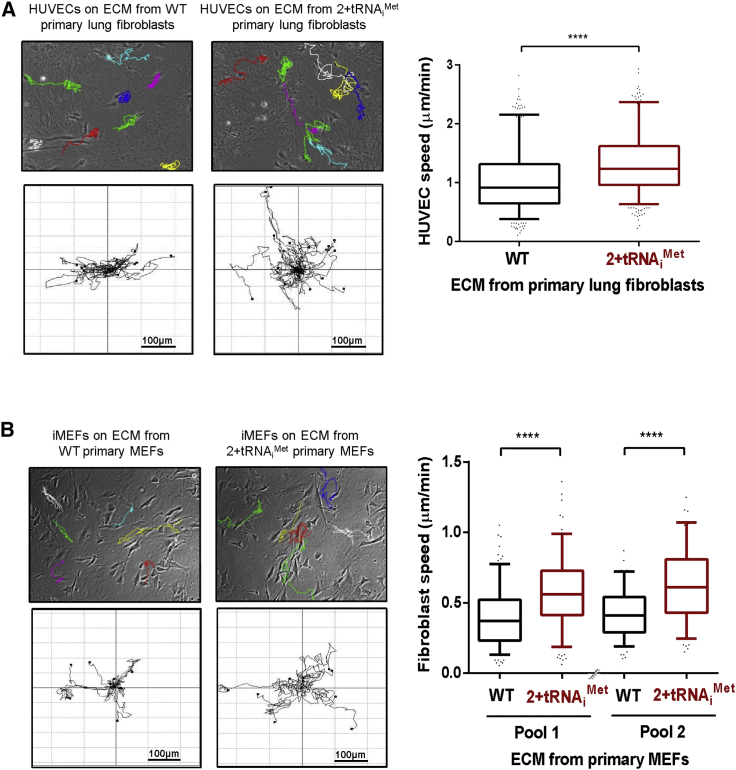
Fibroblasts Isolated from 2+tRNAiMet Transgenic Mice Deposit a Pro-migratory ECM(A) Extracellular matrix (ECM) was generated from primary lung fibroblasts isolated from either wild-type (WT) or 2+tRNAiMet transgenic mice. See Figure S2 for characterization of these cells. Migration of human umbilical vein endothelial cells (HUVECs) on the ECM was recorded by time-lapse microscopy and analyzed using ImageJ. Data represent ECM generated from seven independent isolates of primary fibroblasts from pools of three WT and three 2+tRNAiMet transgenic mice, tracking the migration of at least 28 HUVECs in each replicate. Box and whisker plot represents 5–95 percentile; Mann-Whitney test; ∗∗∗∗p < 0.0001.(B) ECM was generated from primary fibroblasts isolated from either WT or 2+tRNAiMet primary mouse embryonic fibroblasts (MEFs)—these cells are characterized in Figure S2. Migration of immortalized MEFs (iMEFs) on the ECM was recorded by time-lapse microscopy over a 17-hr time course and analyzed using ImageJ. Data represent ECM generated from primary fibroblasts from two pairs of litter-matched WT and 2+tRNAiMet transgenic mice, tracking the migration of at least 60 iMEFs in each replicate; n = 3 for pair 1; n = 2 for pair 2. Box and whisker plot represents 5–95 percentile; Mann-Whitney test; ∗∗∗∗p < 0.0001.